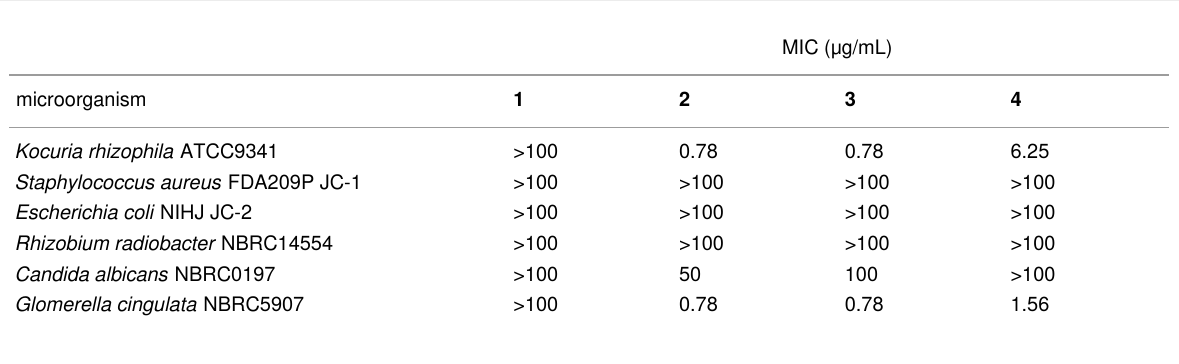
Table 3: Antimicrobial activity of pseudosporamide ( 1 ) and pseudosporamicin A–C ( 2 – 4 ).